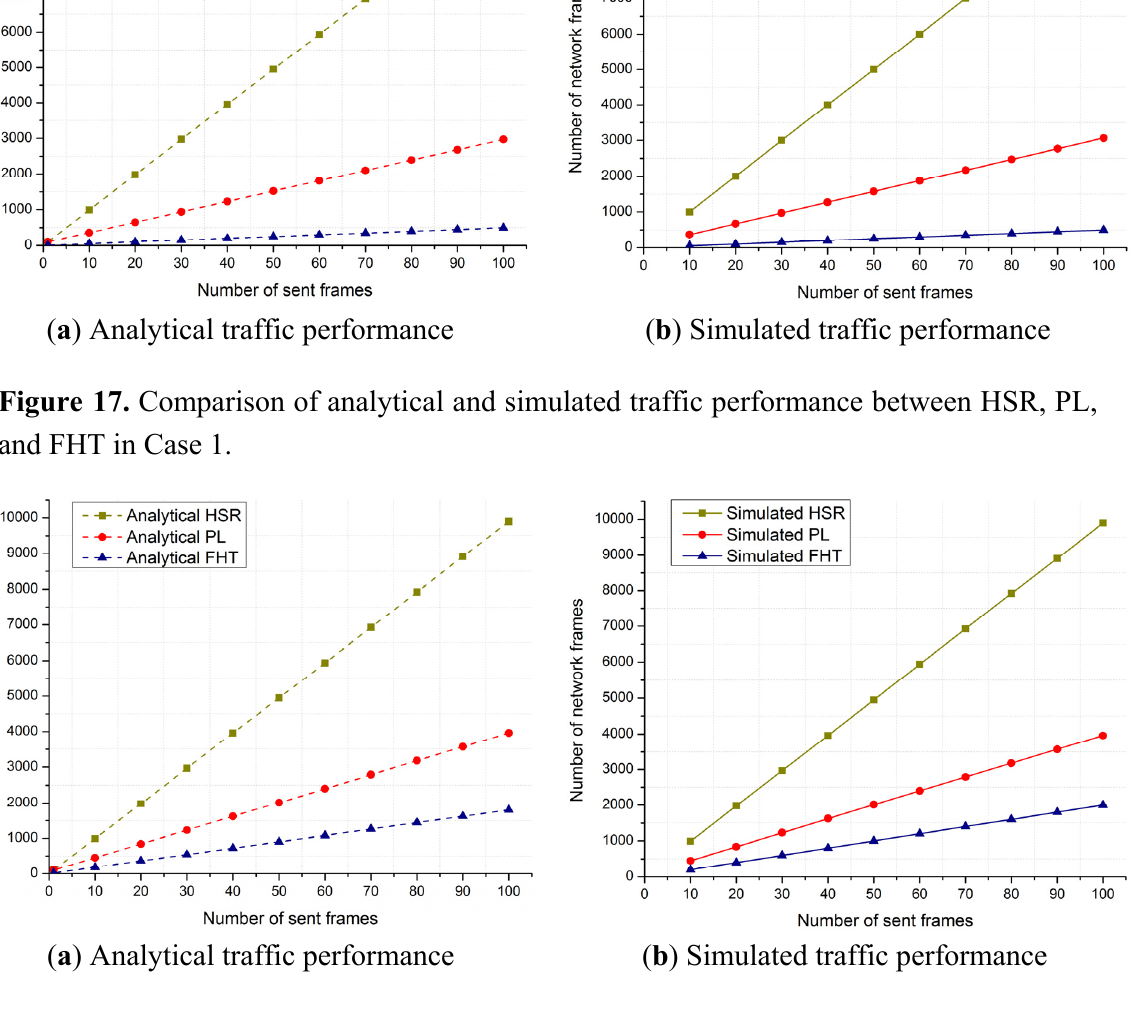
Figure 18. Comparison of analytical and simulated traffic performance between HSR, PL, and FHT in Case